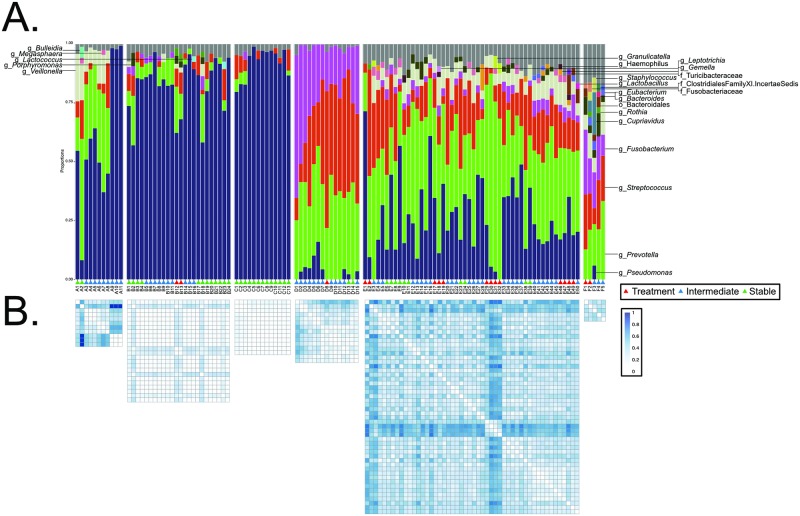
The effects of exacerbation on the lung microbiome are not consistently seen at the community level.A. Taxonomic summaries of all samples sequenced. These summaries indicate that changes to the lung microbiome upon exacerbation are not often obvious when examining the community-wide taxa composition. Taxa present at <2% are summarized in the gray bar. Participant E experienced 4 exacerbations during the study period which are indicated with black lines. B. Heatmaps indicate the Bray-Curtis dissimilarity between each sample. Here, we can see that samples taken during some exacerbations are more dissimilar to those collected during stability; however, this is not true for every exacerbation. These observations are qualified by statistical measures (S2 Table) and were independent of FEV1 (S3 Table).